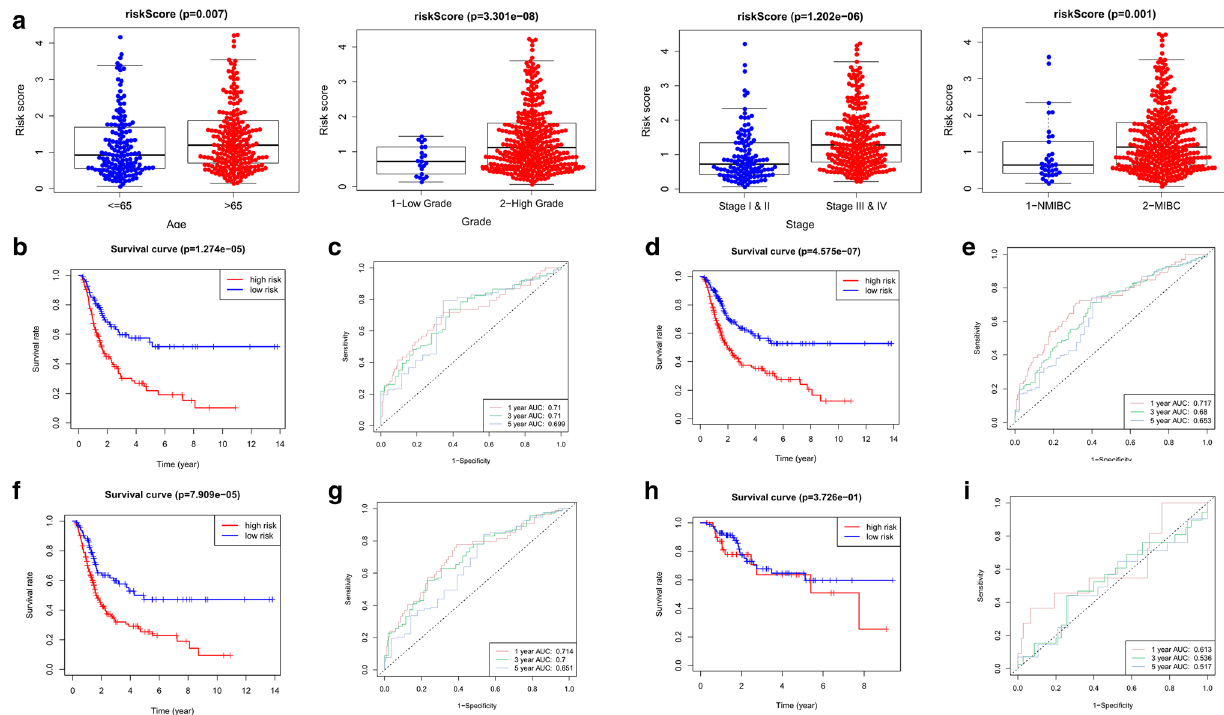
Figure 6. Relationship between risk score/signature and clinical characteristics. ( a ) Analysis of risk score in age, grade, stage and subtype. Results of stratified analysis: ( b , c ), age > 65; ( d , e ), age ≤ 65; ( f , g ) stage III and IV; ( h , i ) stage I and